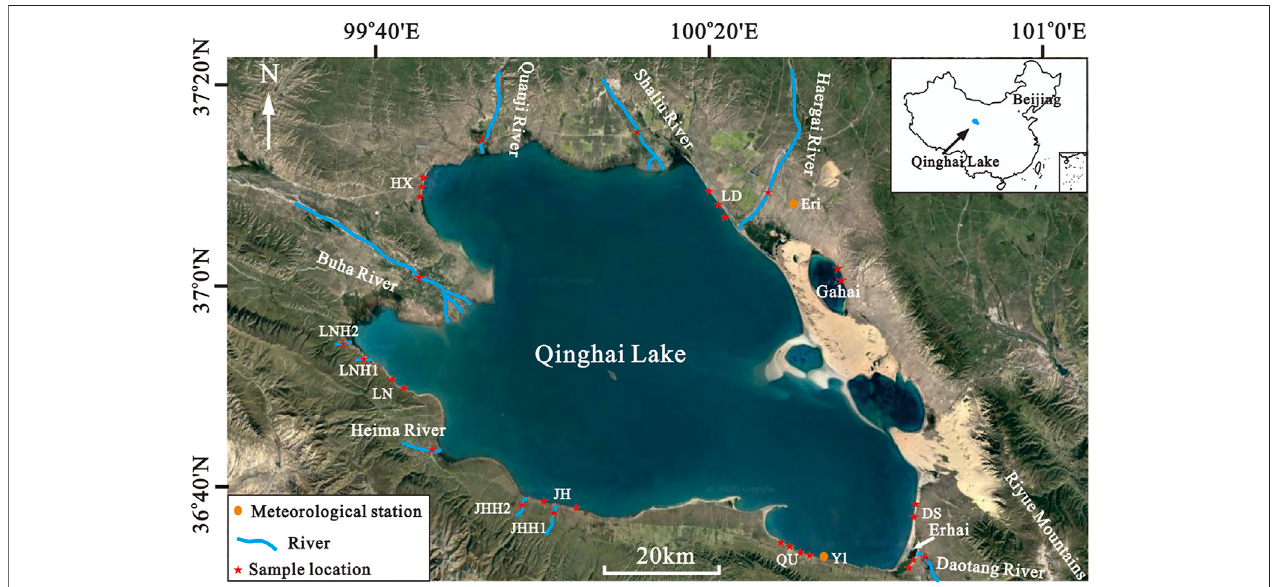
FIGURE 1 | Location of the study area (satellite data taken from Google